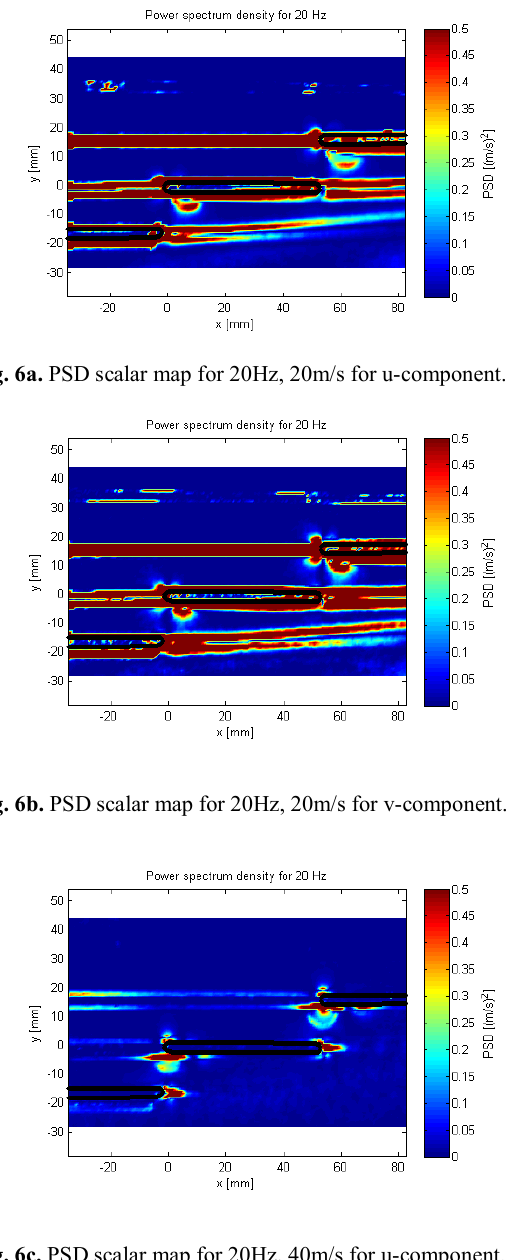
Fig. 6c. PSD scalar map for 20Hz, 40m/s for u-component.